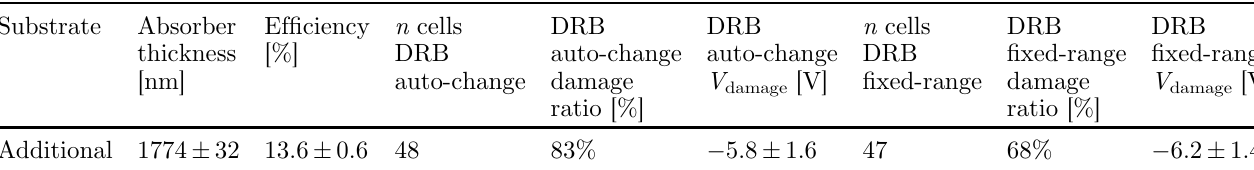
Table A.1. Parameters of additional substrate, including the average absorber thickness, solar cell ef fi ciency and damage voltage for both the dark (DRB) reverse bias sweeps with auto-change and fi xed current range. The average values are based on more than 30 measurement points per substrate, the error is the standard deviation. Also in the table is the percentage of cells that were damaged in sweeps with auto-change and fi xed current range together with the number of cells ( n ) used to calculate this damage ratio.